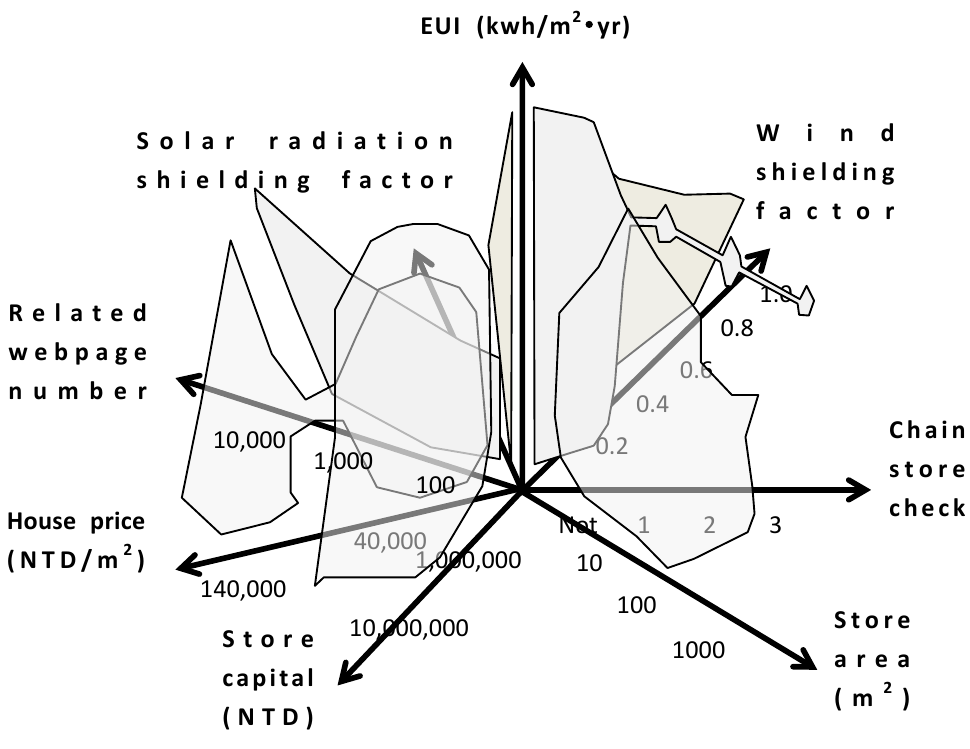
Figure 5. With EUI and collected data summarized in Figure 4, an eight-dimensional (8D) data array is constructed as a sensor core to investigate energy-saving potential on the